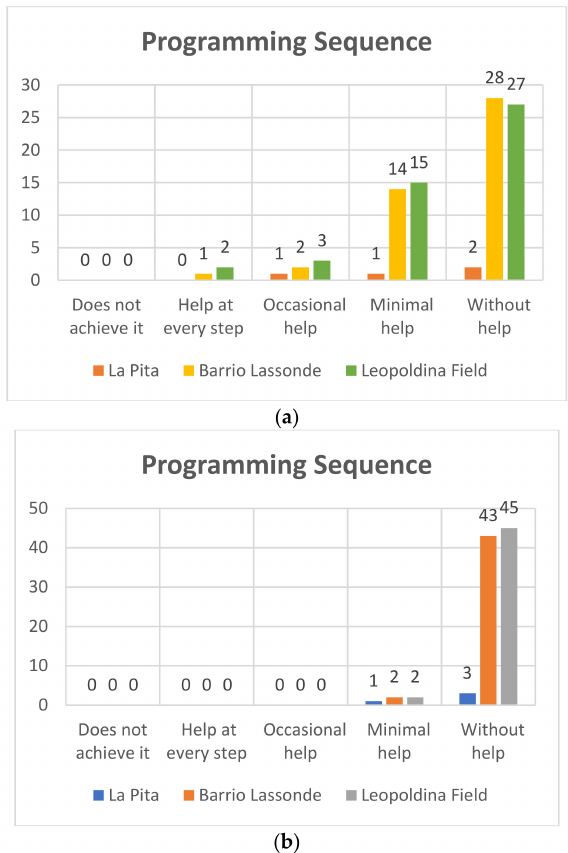
Figure 9. Kindergarden programming sequence Pre-Test ( a ) and Post-Test ( b